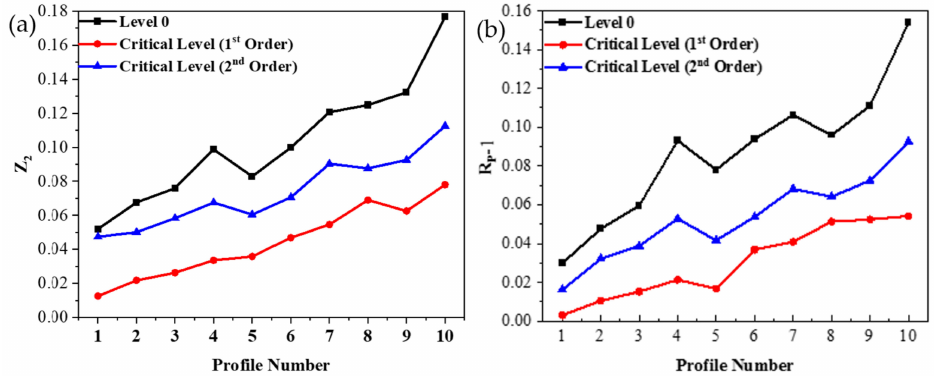
Figure 14. Statistical parameters of the standard JRC profile at critical decomposition levels ( a ) Statistical parameter Z 2 , ( b ) Statistical parameter R P -1.